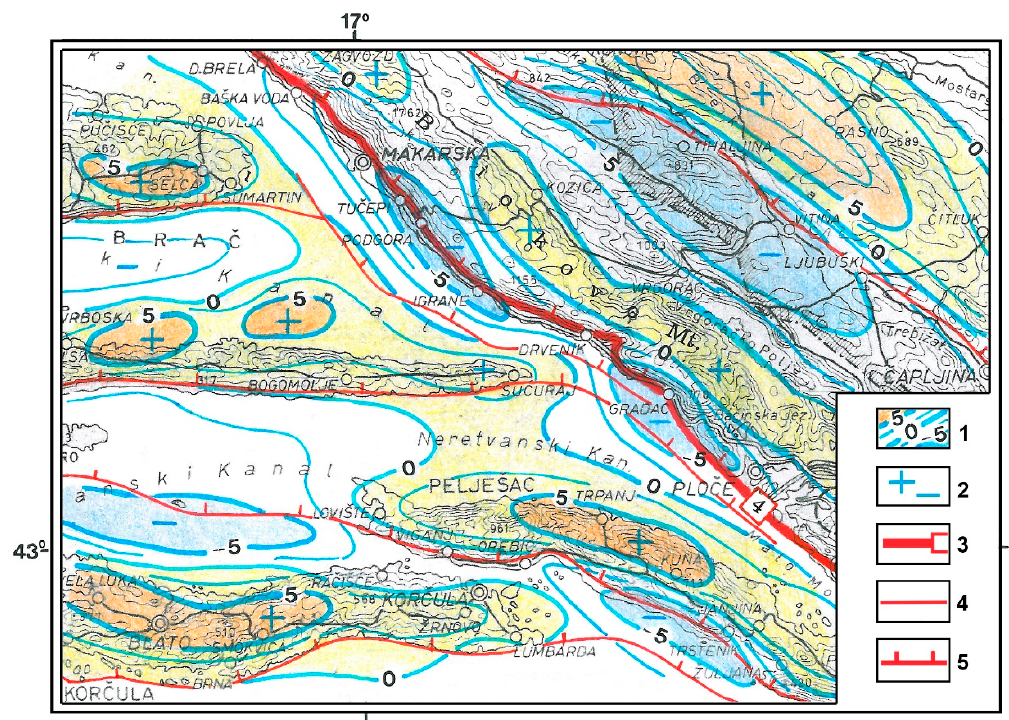
Figure 8. Gravimetric residual anomalies in the area of southern Adriatic islands and Biokovo. Legend: 1—Isolines of anomalies in mgal; 2—the highest positive and negative values of mgal; 3—major Mosor-Biokovo-Dubrovnik fault (4), borders of regional structural units; 4—faults extending along large local elevated reverse structures of vergences toward S and SSW–SW; 5—mark for reverse faults.